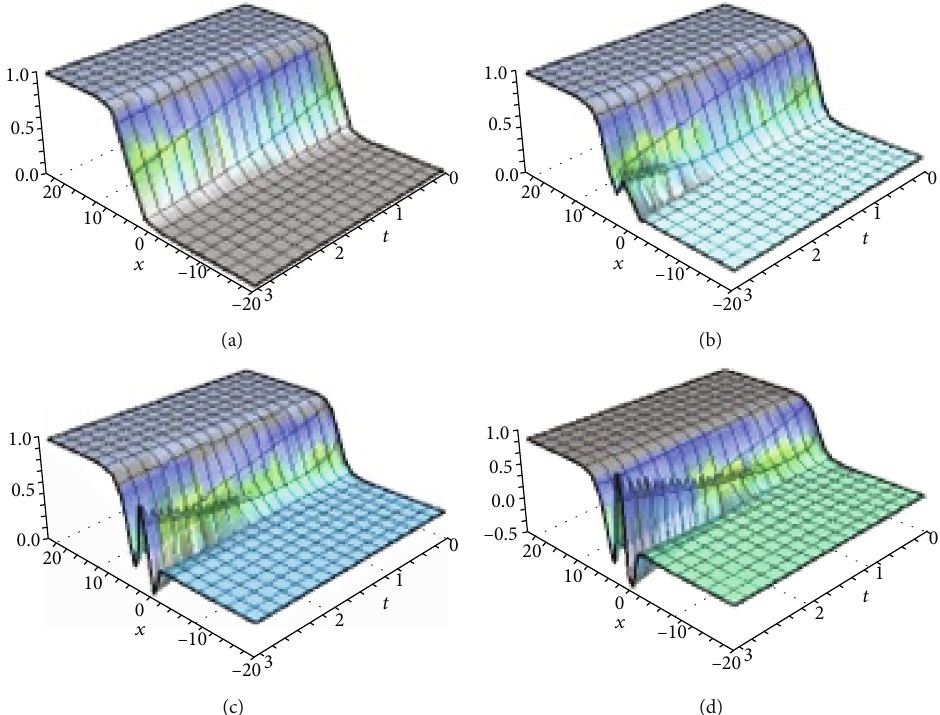
x , t Þ of FGEs (21) and (22) with λ = 1 for diverse α : (a) exact, (b) α = 0 : 75 , (c) α = 0 : 5 , and 4 ð